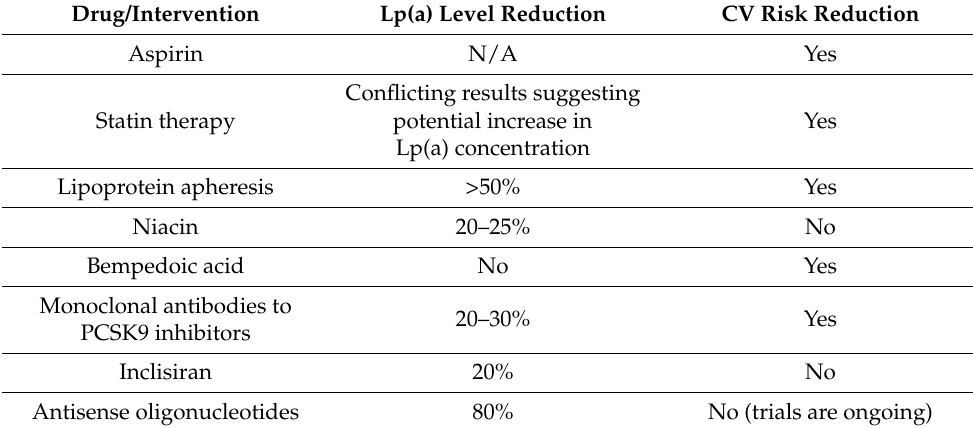
Table 2. Effects of lipid-lowering agents on Lp(a)